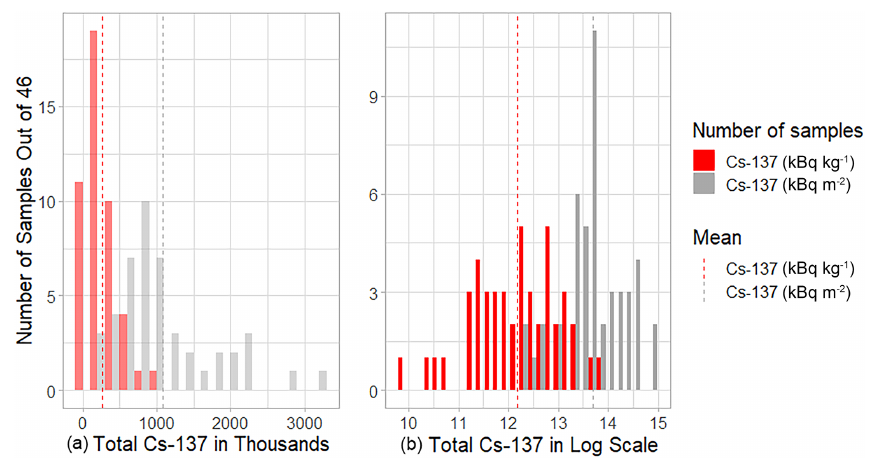
Figure 4. Distribution of mass-based total Cs-137 in a core sample. (a) A unit of each bin is 200k. (b) Distribution of total mass depth Cs-137 in a core sample in a log scale (red: Cs-137 kBqkg − 1 ; gray: Cs-137 kBqm − 2 ).